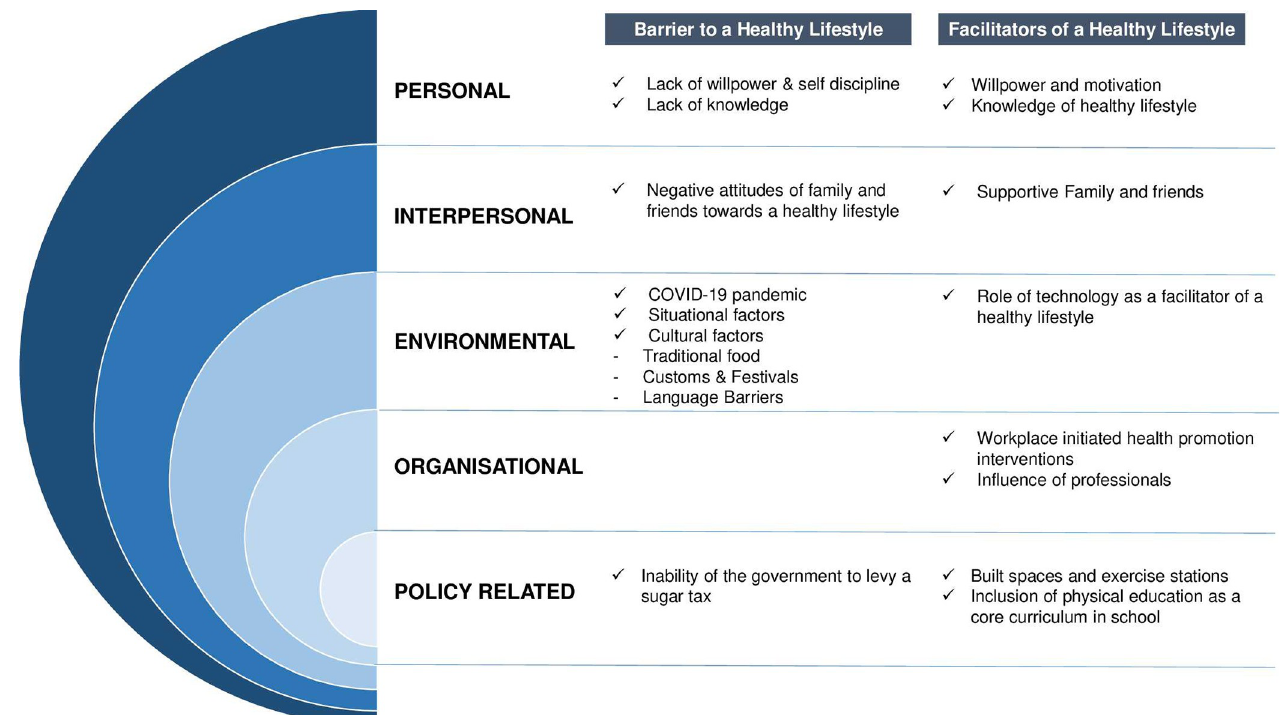
Fig 1. Barriers and facilitators of adopting a healthy